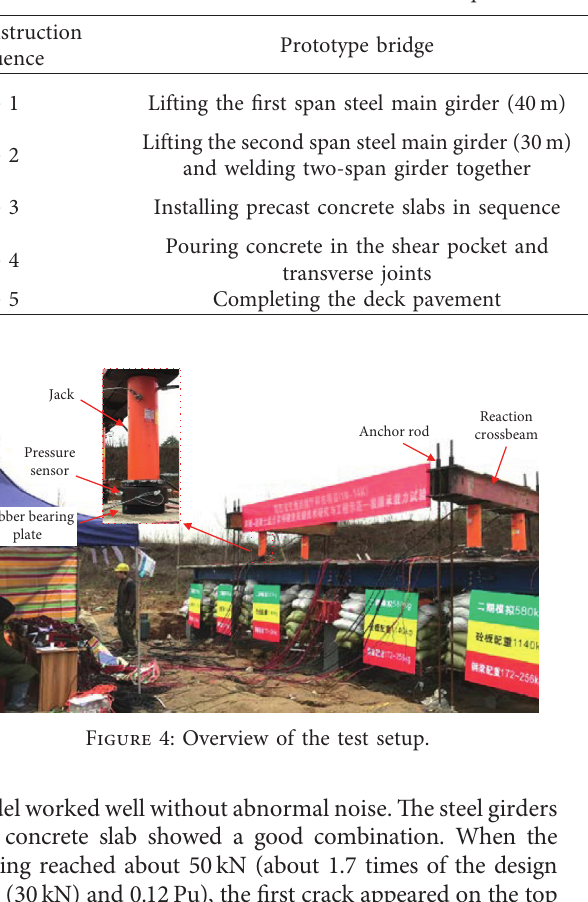
Table 4: Construction sequence of the bridge model and prototype bridge.